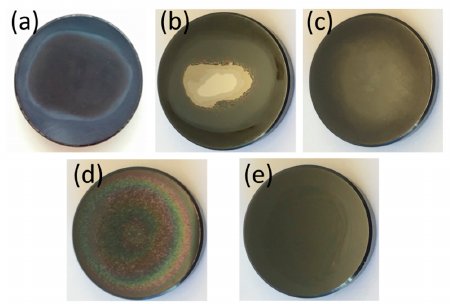
Figure 3. Typical macroscopic appearances of ( a ) a reacted surface (Standard), ( b ) a failed coating (Nb-medium), and ( c , d ) coatings with a surface layer: ( c ) Coating Cr and ( d ) coating Si Power-high. In ( e ) a Bias-high coating is shown, which did not present any layer formation or upcoming failure up to 2 MC.